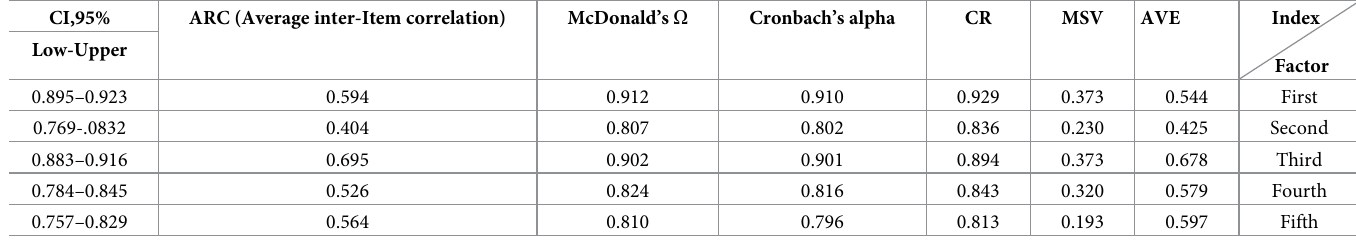
Table 3. Convergent and divergent validity, internal stability and structural stability of questionnaire of evaluation of school resilience in emergencies and disasters. CI,95% ARC (Average inter-Item